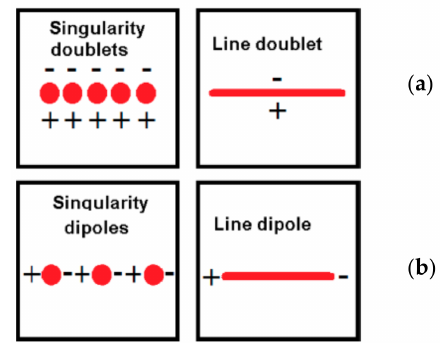
Figure 9. Visualization of ( a ) line doublet, and ( b ) line dipole. ( a , b ) are obtained by superposing an infinite number of singularity doublets and singularity dipoles, respectively. Reproduced with permission from